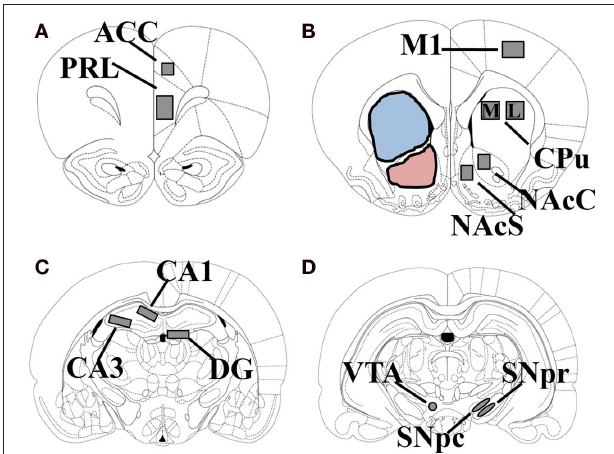
Figure 1 | Schematic diagram of the rostral to caudal sections of rat brain used for analysis of malondialdehyde immunoreactivity (MDA-ir) and tyrosine hydroxylase immunoreactivity (TH-ir). Measurements given are relative to bregma. The regions used for analysis of MDA-ir are highlighted in gray and consist of the PRL and ACC ( + 4.2 mm; A ); NAc, CPu, and M1 ( + 1.7 mm; B ); hippocampus ( − 2.92 mm; C ); SN and VTA ( − 4.92 mm; D ). PRL, prelimbic cortex; ACC, anterior cingulate cortex; NAcC, nucleus accumbens core; NAcS, nucleus accumbens shell; CPu, caudate putamen; M1, primary motor cortex; DG, dentate gyrus; SNpc, substantia nigra pars compacta; SNpr, substantia nigra pars reticulata; VTA, ventral tegmental area. The areas used for analysis of TH-ir are highlighted in blue (CPu) and